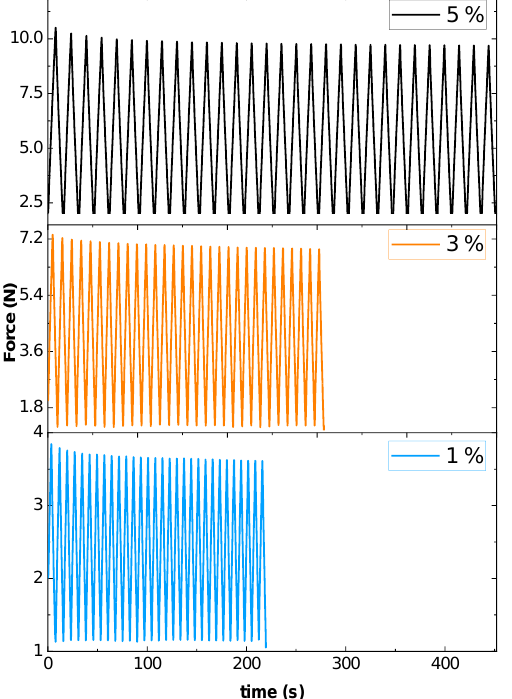
Figure 5. Mechanical load response under cycling testing for 1, 3 and 5% strain levels for 7 wt.% nanocomposite.